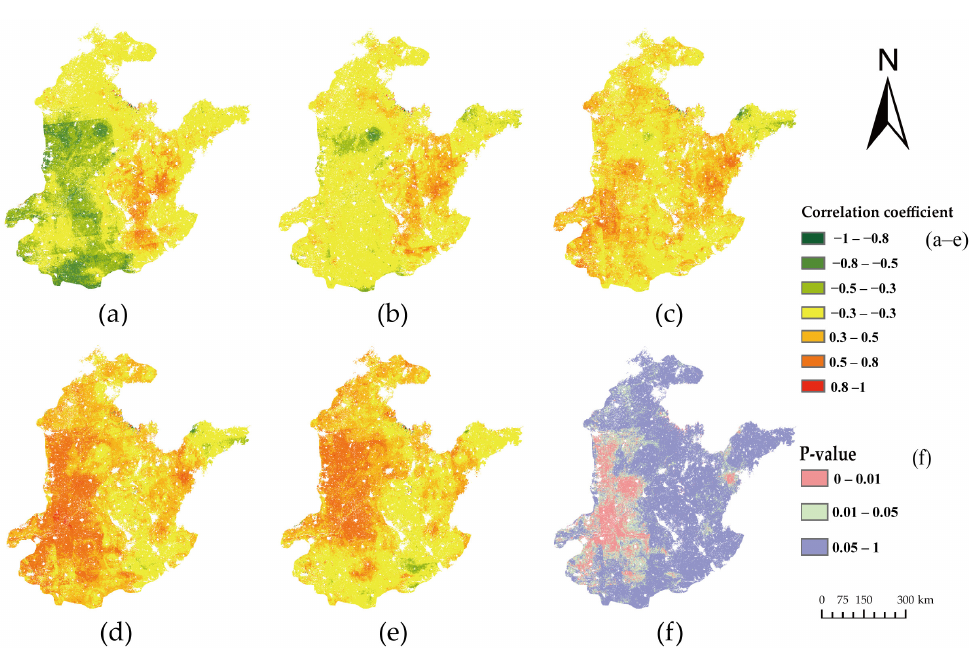
Figure 10. ( a ) The correlation analysis without lag; ( b ) the correlation analysis with a lag of 1 month; ( c ) the correlation analysis with a lag of 2 months; ( d ) the correlation analysis with a lag of 3 months; ( e ) the correlation analysis with a lag of 4 months; and ( f ) a significant test with a lag of 3 months.